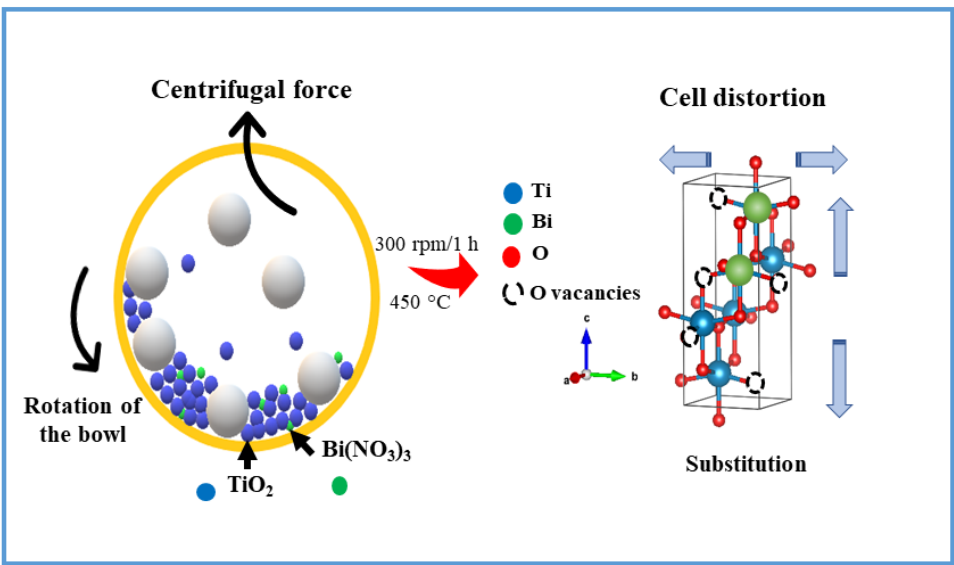
Figure 10. Scheme of the effect of grinding and bismuth doping on the crystalline lattice of TiO 2 anatase phase.